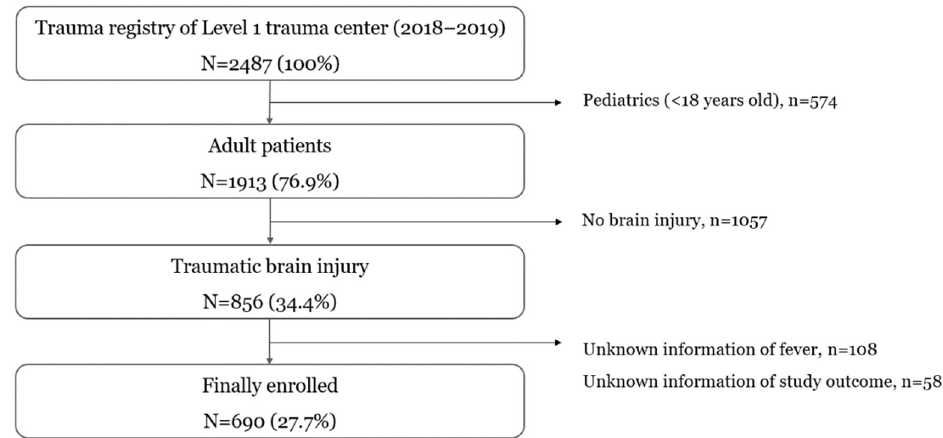
Figure 1. Study Figure 1. Study populations .